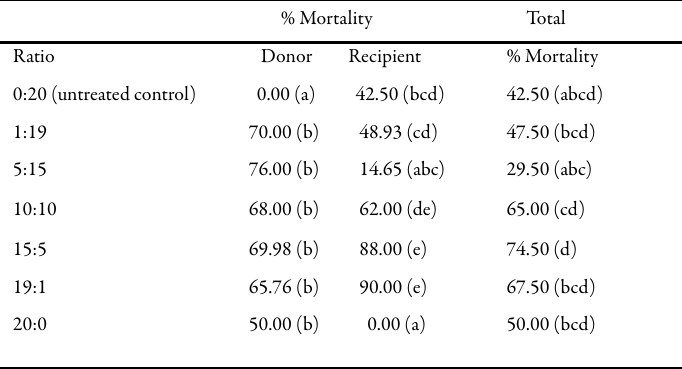
Table 1. Mean percent mortality at 7 d post-treatment of FST donors and recipients when donors were treated with 50 ppm chlorantraniliprole.